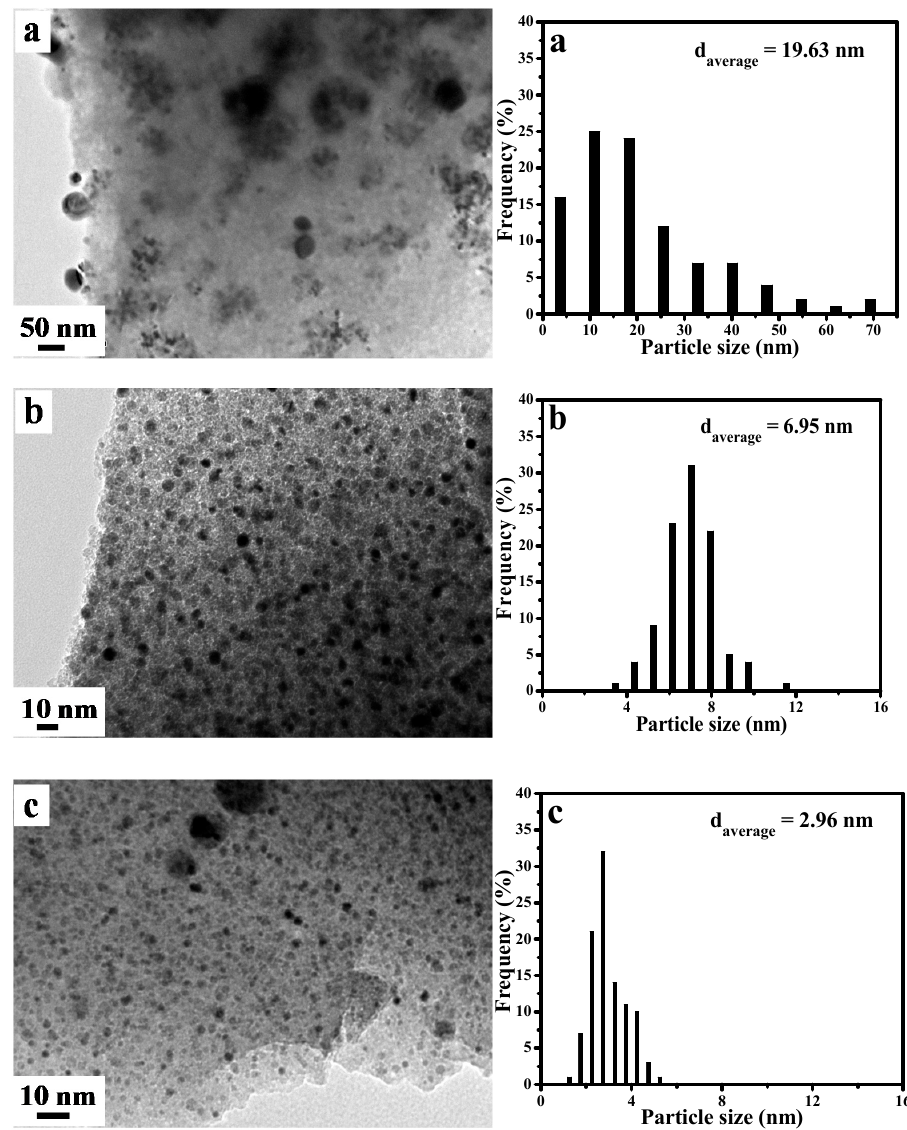
Figure 3. TEM images and particle size distribution of the reduced Ni/SiO 2 ( a ), Ni-G-2/SiO 2 -C ( b ), and Ni-G-2/SiO 2 -P ( c ) catalysts.